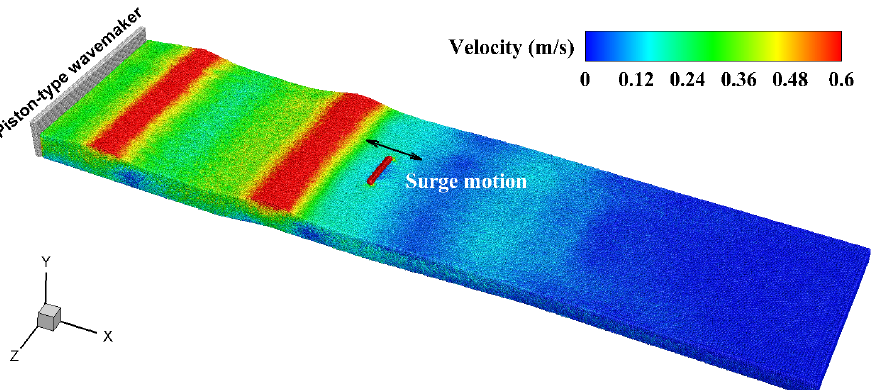
Figure 17. The snapshot of a working OWSC solved by the “SPHinXsys + Simbody” strategy. Note that this snapshot is adapted from [135] with its author’s kind